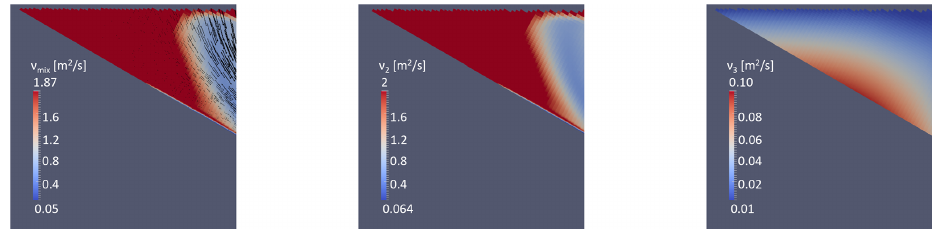
Figure 1. Viscosity distribution (indicated by color scale) along a 28cm long section through the modeled 0.01m 3 release block 0.2s after release, corresponding to the experimental setup of Hürlimann et al. (2015). The starting motion (black velocity arrows) with corresponding viscosity distribution of the mixture (left) is a consequence of blending pure shear-rate-dependent slurry-phase rheology (center) with the pressure- and shear-rate-dependent gravel phase rheology that accounts for Coulomb friction (right). Because the gravel concentration in this example is low, its effect on the overall viscosity is